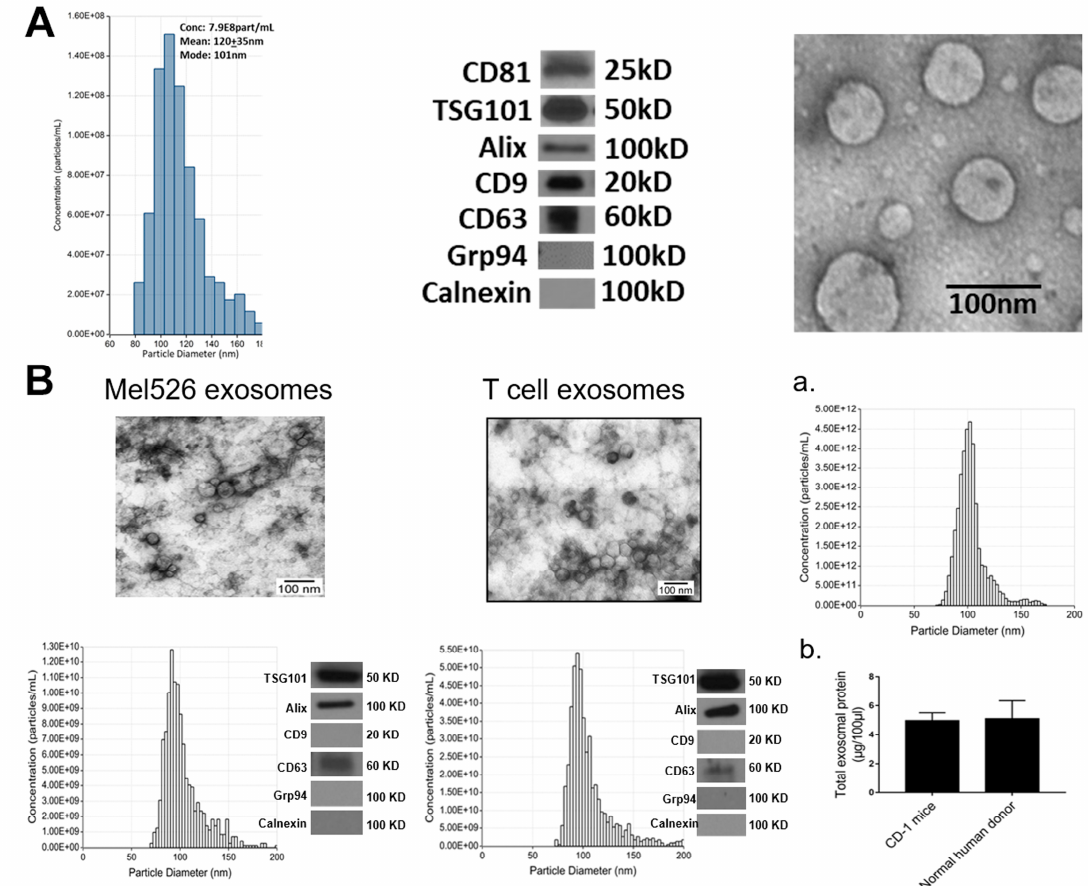
Figure 1. Exosome characterization: ( A ) Exosomes were isolated from supernatants of Kasumi-1, a human leukemia cell line using mini-SEC as described in Materials and Methods. Exosomes in Fraction #4 were harvested and characterized by tunable resistive pulse sensing (TRPS) to determine their diameters and concentrations (left); by Western blots to show the presence of exosome markers and absence of cytoplasmic proteins (middle); and by TEM to illustrate vesicular morphology and the size range (right). ( B ) The TEM images, size distribution profiles and Western blot profiles of Mel526 exosomes (left) and exosomes produced by human T cells (middle). ( a ) The size distribution profile of circulating exosomes in CD-1 mouse plasma; ( b ) comparisons of total exosomal protein levels of circulating exosomes in the plasma of CD-1 mice and of normal human donors. The data are means ± SD from 3 independent